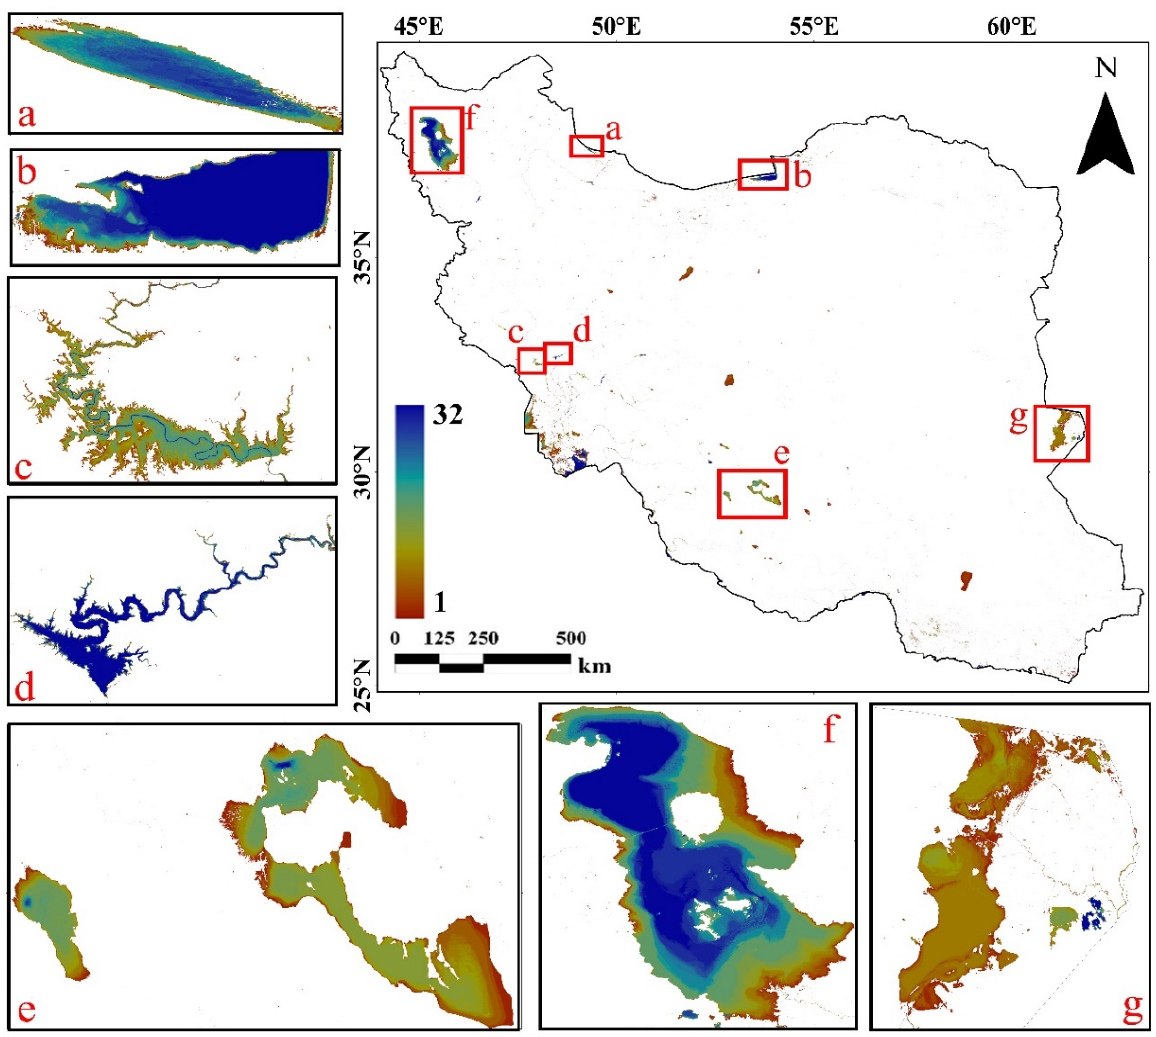
Figure 10. Surface water area frequency map (WFM): ( a ) Anzali lagoon, ( b ) Gorgan gulf, ( c ) Karkhe Reservoir, ( d ) Dez Reservoir, ( e ) Bakhtegan, Tashk and Maharlu lakes, ( f ) Urmia Lake, ( g ) Hamoon lake.